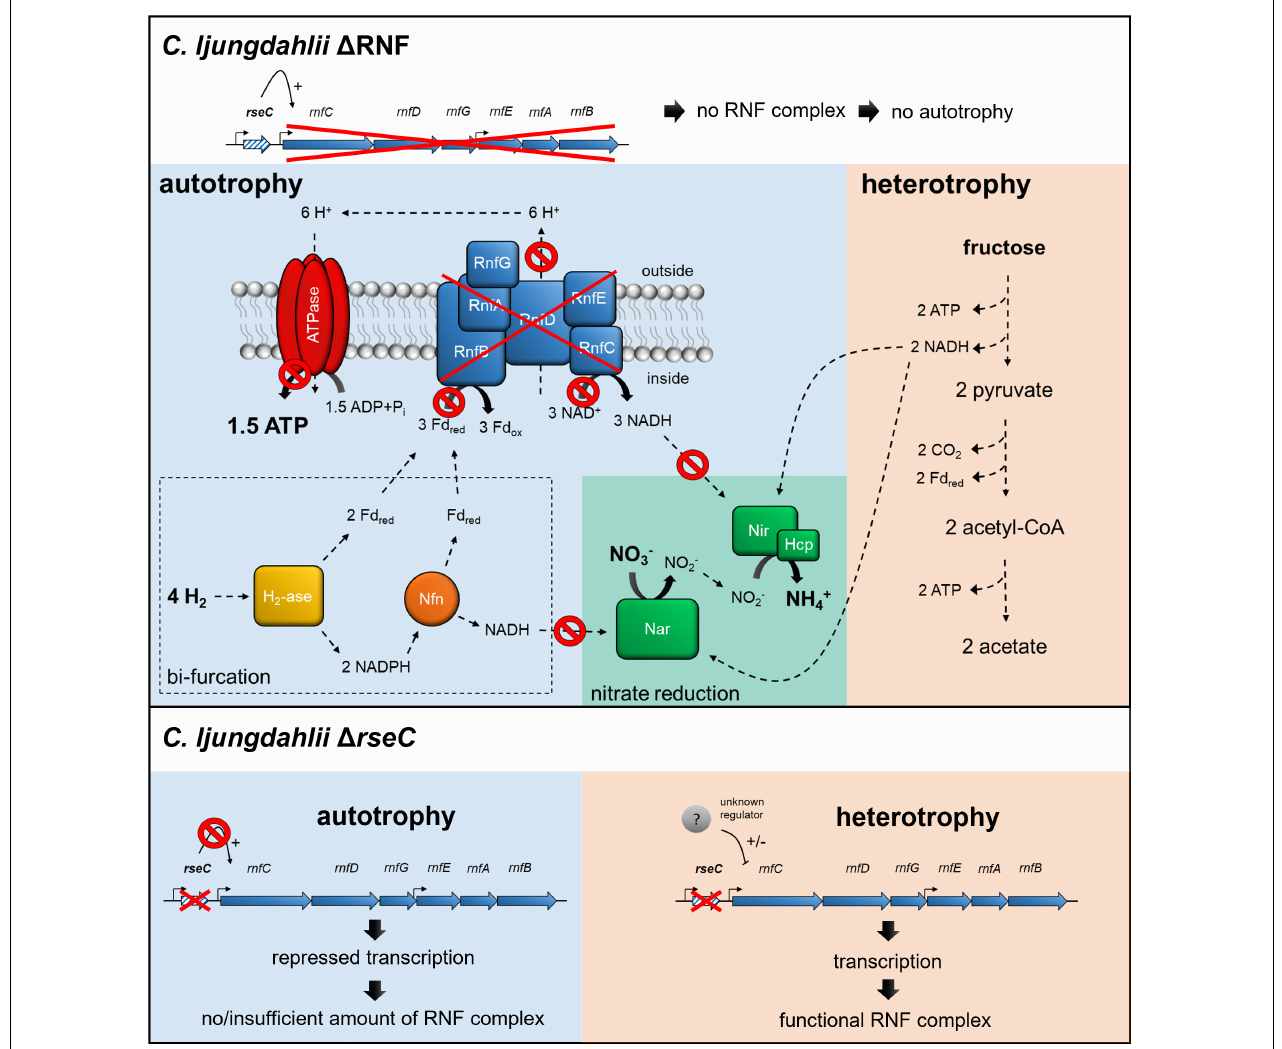
FIGURE 6 | Schematic model of RNF-gene regulation and nitrate reduction in the deletion strains C. ljungdahlii (cid:49) RNF and C. ljungdahlii (cid:49) rseC during autotrophy and heterotrophy. In both deletion strains, nitrate reduction is not possible in non-growing cells during autotrophy with carbon dioxide and hydrogen due to the lack of a functional RNF complex, and thus the missing regeneration of reducing equivalents such as NADH. On the contrary, nitrate reduction can proceed in C. ljungdahlii (cid:49) RNF during heterotrophy with NADH, which is provided by glycolysis of fructose. In C. ljungdahlii (cid:49) rseC , the RNF complex genes are repressed during autotrophy but not during heterotrophy, which indicates a further unknown regulation mechanism during heterotrophy. Thus, a functional RNF complex is formed, and nitrate reduction can proceed such as proposed for the wild type. H 2 , hydrogen; H + , proton, CO 2 , carbon dioxide; NO 3 − , nitrate; NO 2 − , nitrite; NH 4 + , ammonium; ATP, adenosine triphosphate; ADP + P i , adenosine diphosphate + phosphate; Fd red / ox , reduced/oxidized ferredoxin; NADH/NAD + , reduced/oxidize nicotinamide adenine dinucleotide; NADPH/NADP + , reduced/oxidized nicotinamide adenine dinucleotide phosphate; RnfCDGEAB, RNF-complex subunits; Nar, nitrate reductase; Nir, nitrite reductase; Hcp, hydroxylamine reductase; H 2 -ase, bifurcating hydrogenase/lyase; Nfn, bifurcating transhydrogenase; e − , electron; (cid:49) RNF, C. ljungdahlii (cid:49) RNF; and (cid:49) rseC , C. ljungdahlii (cid:49) rseC . The model was adapted from Emerson et al.